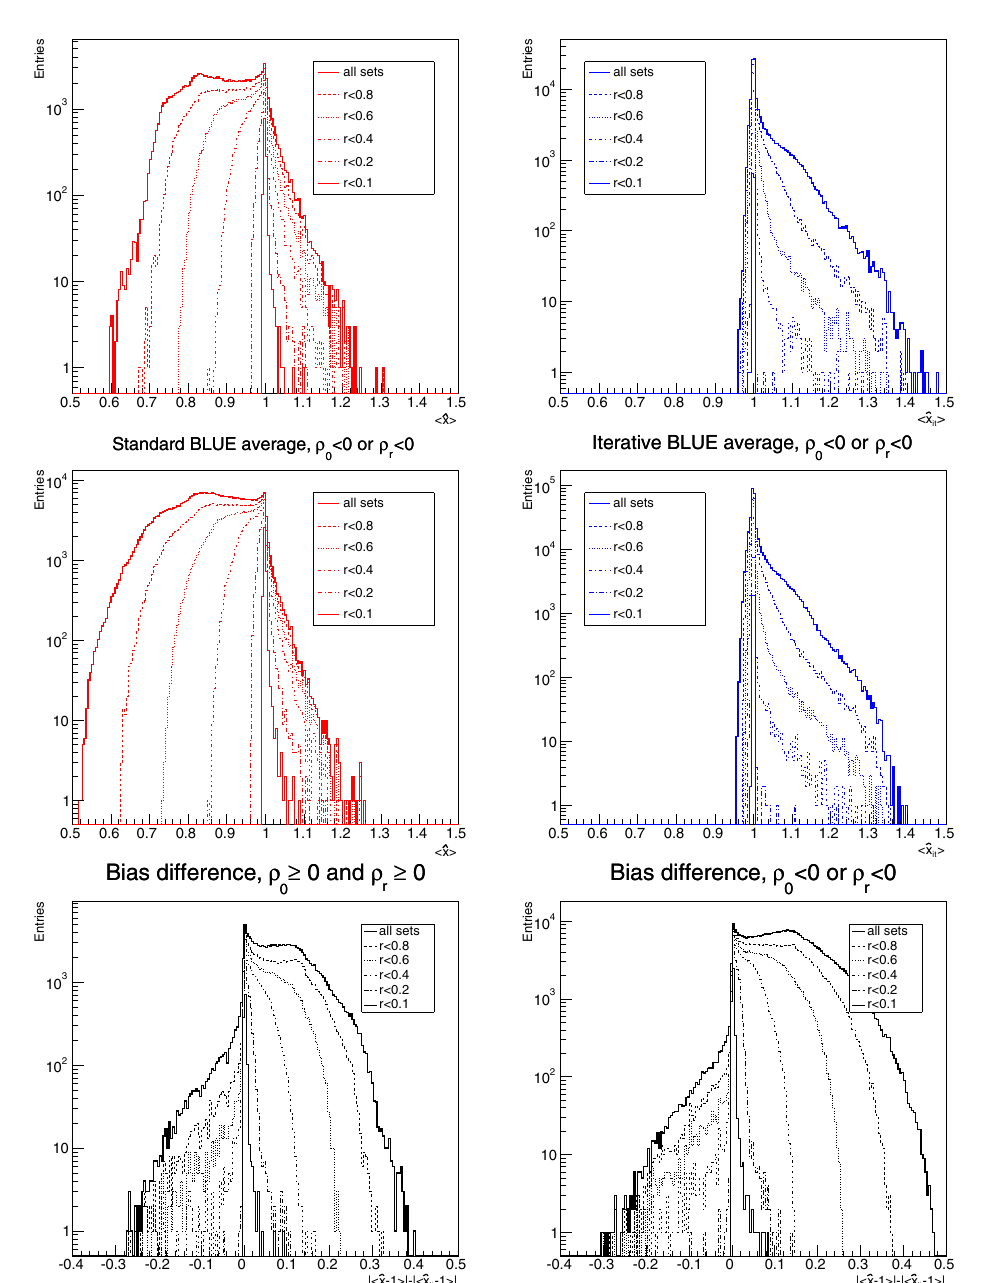
Figure 3. Distribution of the average value of the standard (top and middle, left) and iterative (top and middle, right) BLUE estimates for di ff erent limits on r 1 , 2 and for ρ 0 ≥ 0 and ρ r ≥ 0 (top) and for ρ 0 < 0 and ρ r < 0 (middle). Bottom plots show the di ff erence of measured absolute value of the bias for the standard and iterative BLUE estimates for di ff erent limits on r 1 , 2 and for ρ 0 ≥ 0 and ρ r ≥ 0 (left) and for ρ 0 < 0 and ρ r < 0 (right). Positive values indicate a smaller bias in the iterative method compared to the standard method. Underestimate of the uncertainty (negative values) occur in fewer cases with the iterative BLUE method than with the standard BLUE method. The figure is from ref.